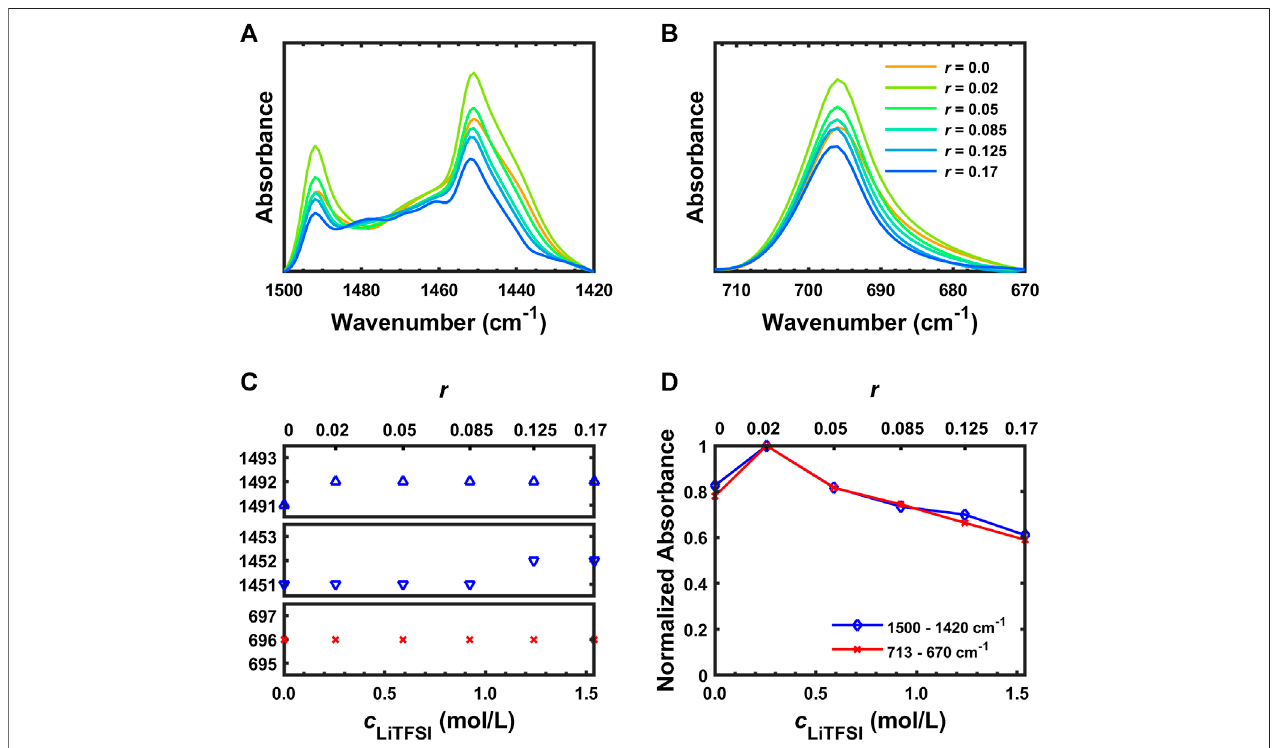
FIGURE 2 | (A) FTIR-ATR spectra of SEO/LiTFSI between 1,500 and 1,420 cm − 1 , (B) FTIR-ATR spectra of SEO/LiTFSI between 713 and 670 cm − 1 , (C) peak positions of δ CH 2 + phenylgroup and ρ CH 2 , and (D) normalized integrations of (A) and (B)